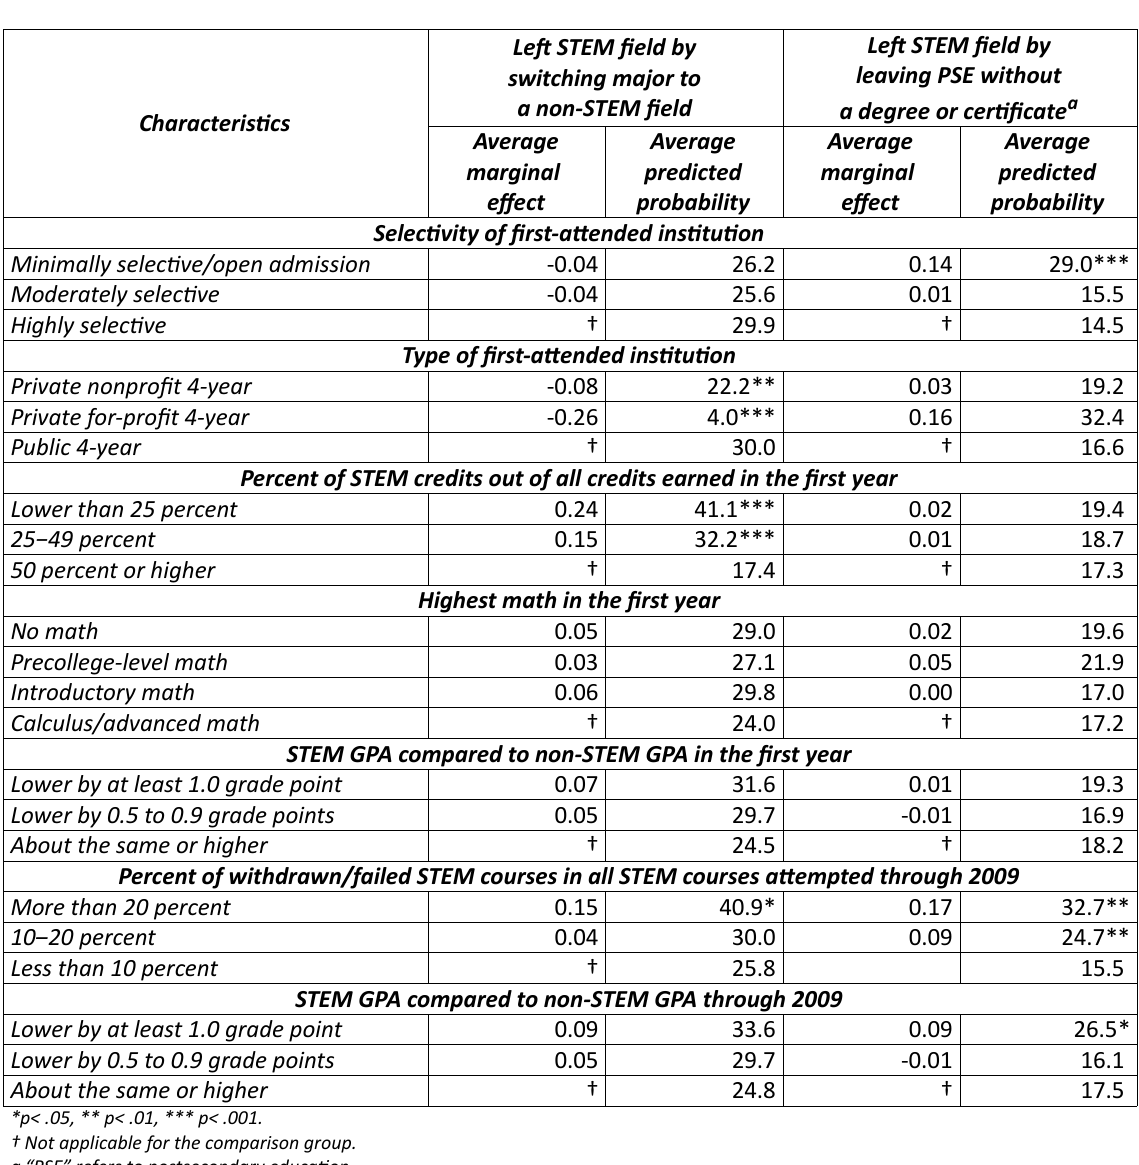
Table 5. Average marginal efects of various characteristcs on the probability of STEM entrants leaving STEM felds, and the average predicted probability of leaving STEM felds among various groups of